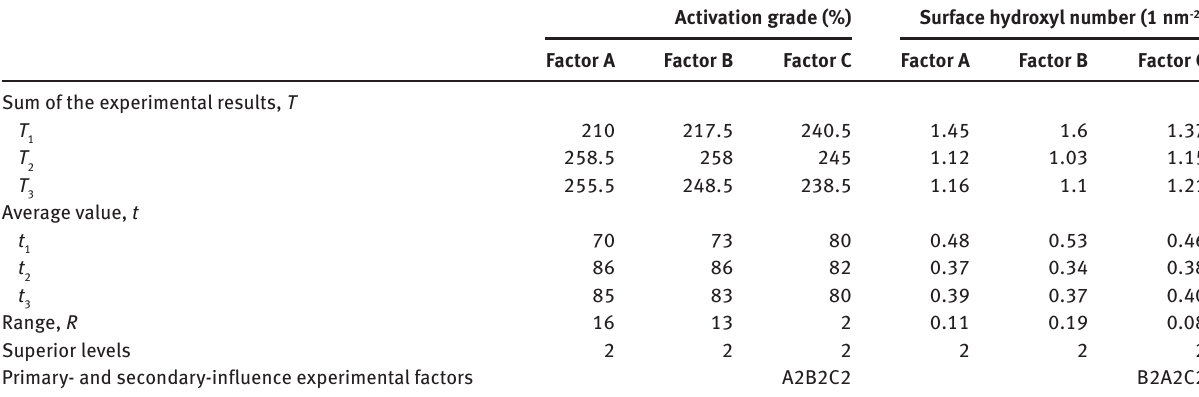
Table 5 Analysis of orthogonal test results.